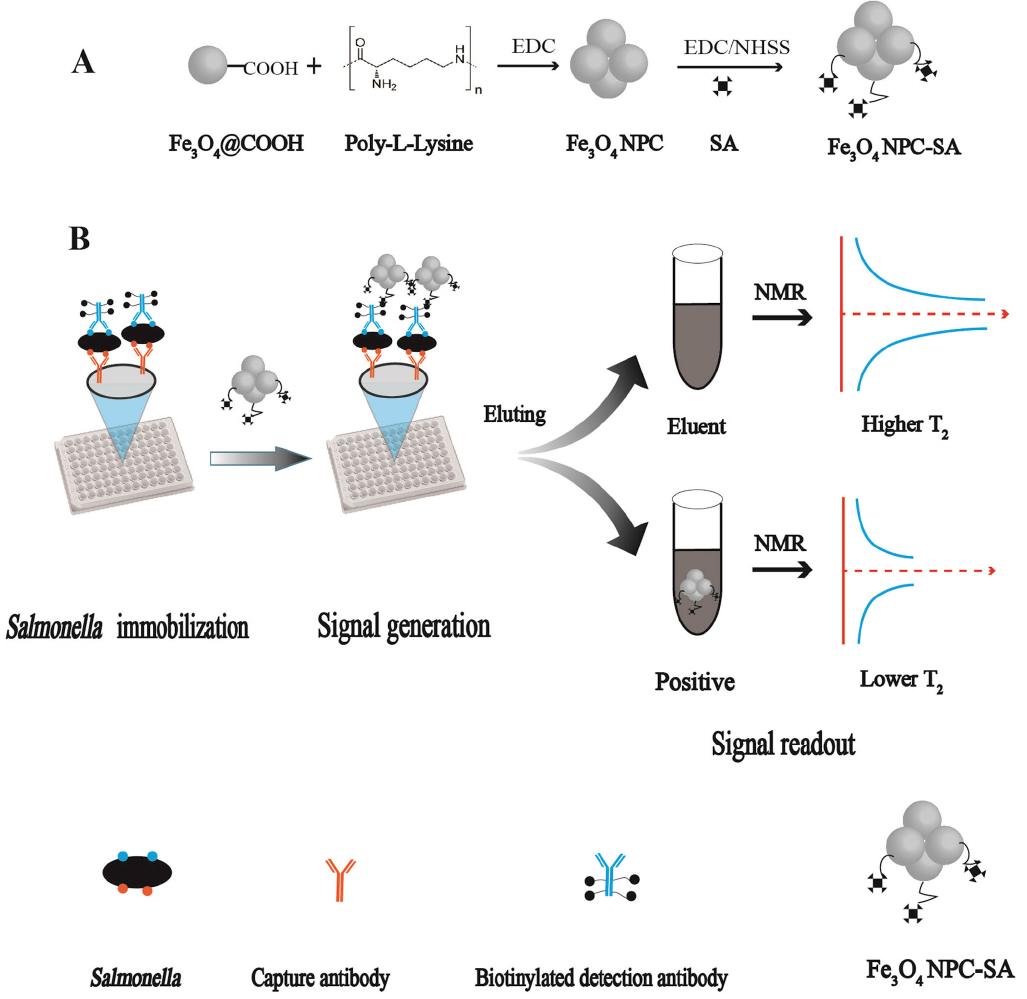
Figure 10. NMR biosensor based on nuclear magnetic resonance for detection of Salmonella: ( A ) representation for preparation of Fe 3 O 4 nanoparticles (NP) and Fe 3 O 4 -streptavidin nanoparticles (NPC-SA); ( B ) overview of NMR biosensor for detection of Salmonella in milk (reprinted with permission from [124]).